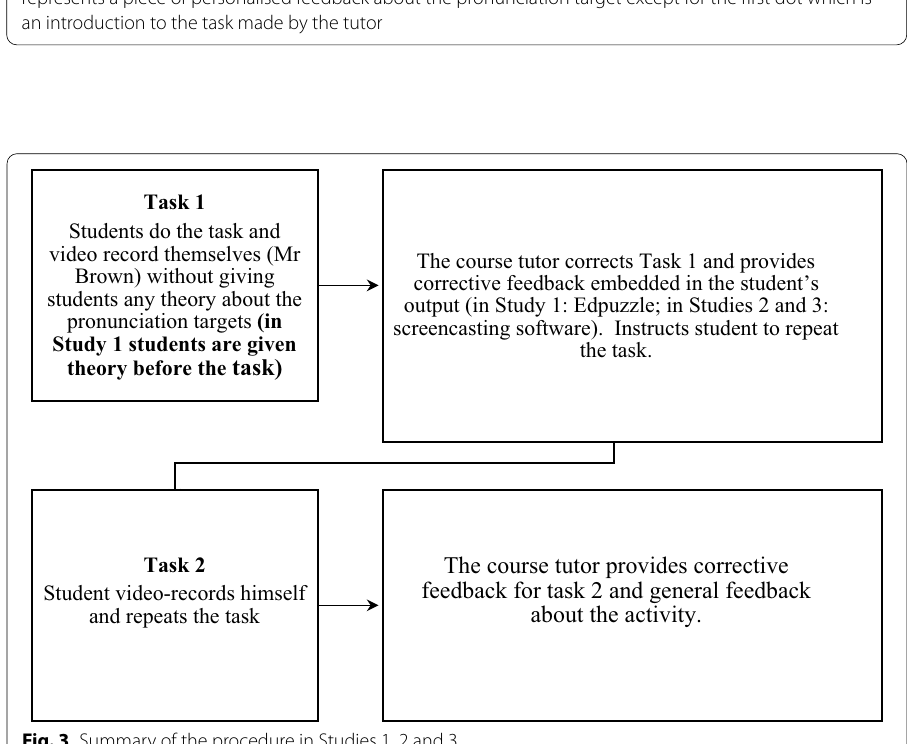
Fig. 3 Summary of the procedure in Studies 1, 2 and